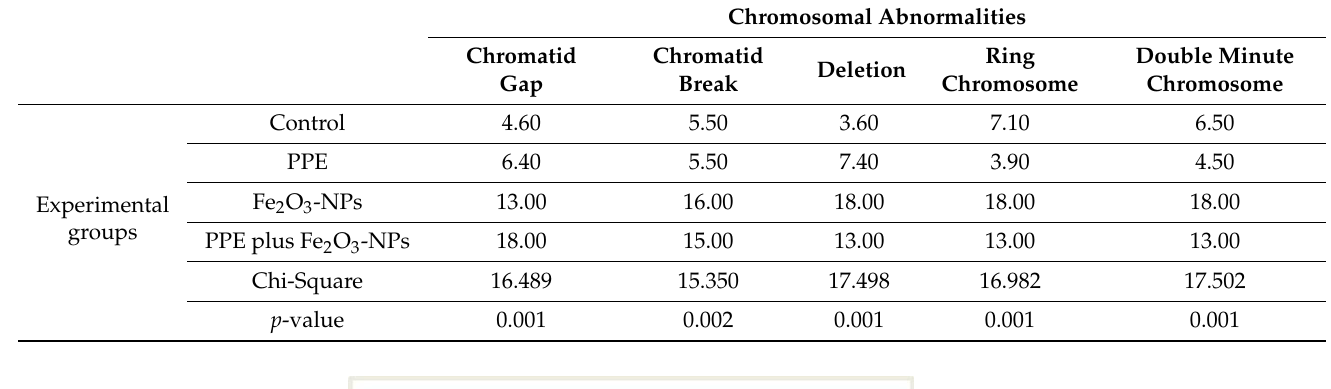
Table 3. The abnormal types of chromosomes for different experimental groups.